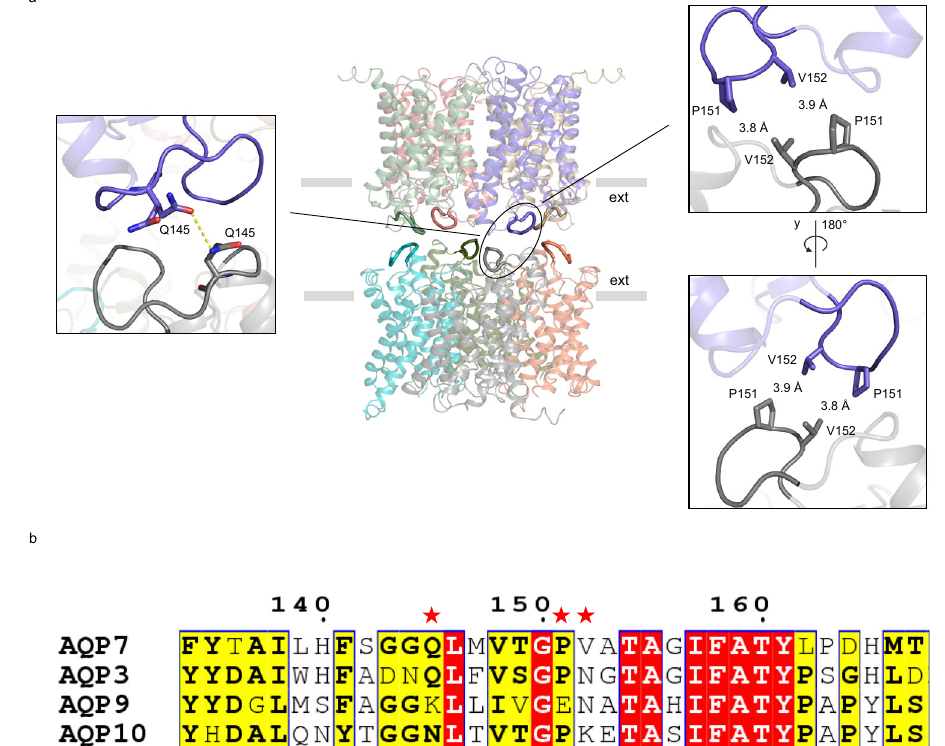
Fig. 4 | AQP7 tetramersadhere via loopC. a Cryo-EMstructureshown ascartoon and the loop C of each monomer is highlighted as tube, contributing residues as sticksandhydrogenbondsshownasyellowdashedlines. b Sequencealignmentby CLUSTALW (version 2.1) of loop C among the human aquaglyceroporins. Residues